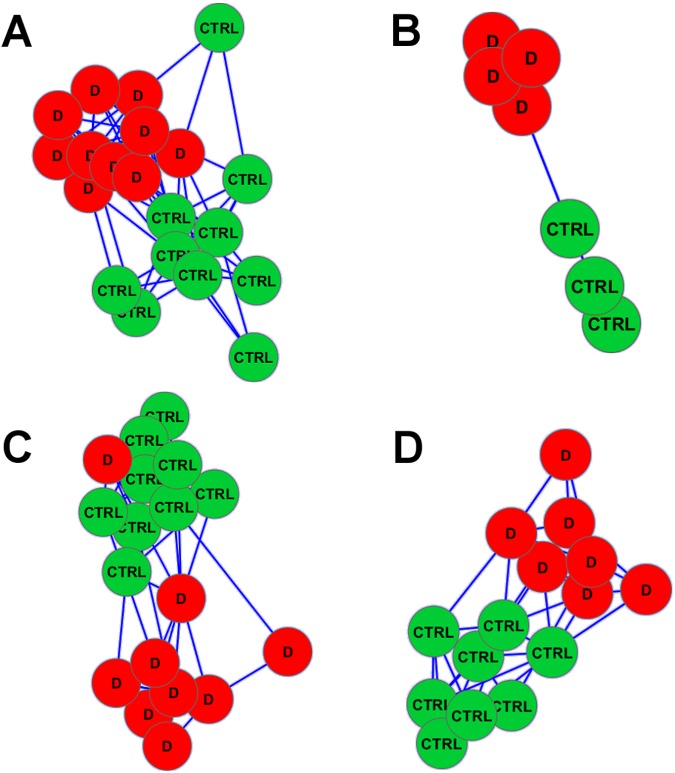
Networks of subject groups in each replication study of the ASCM pathway.Networks represent subjects’ classification in the four replication studies of the ASCM pathway as a provider of classification effective biomarkers of IR-related disorders. Nodes represent subjects (green ones are healthy subjects, red ones are diseased). The edge length is proportional to the difference between the subject signatures (short edges indicate high similarities, long edges indicate low similarities, no edge indicates a negligible similarity). In each case subjects naturally cluster together according to the class they belong to. A: classification of 10 healthy donors and 10 T2DM donors [35]. B: classification of 3 healthy controls versus 4 NICM patients [36]. C: classification of 9 healthy controls versus 9 CHF patients [37], in this case a diseased subject is miss-classified by the algorithm. D: classification of 8 control donors and 7 AD patients’ autopsies [38]. Networks were drawn through Cytoscape [40]. See also S4 Table.